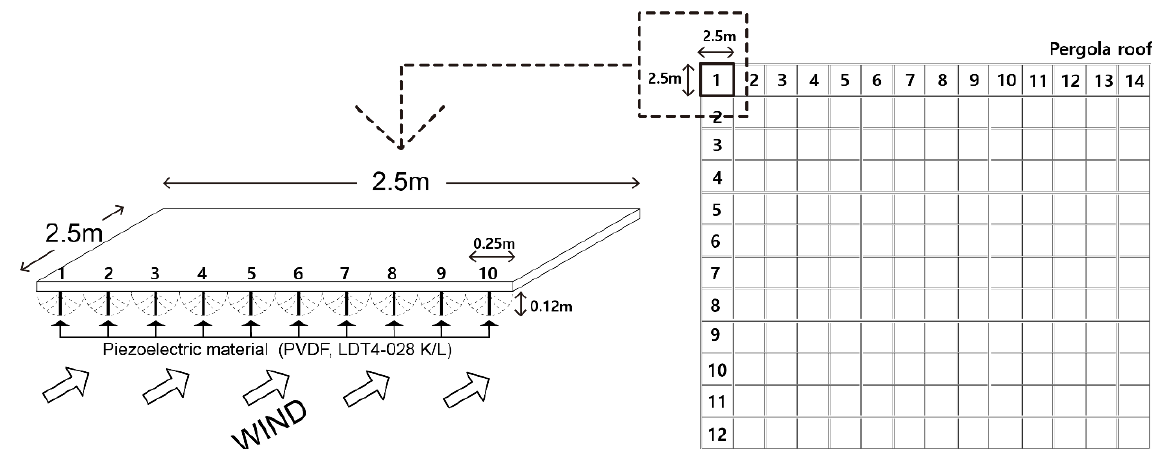
Figure 11. Installation plan of piezoelectric materials to be installed under the roof of the pergola at Lanzarote Dynamic Square.